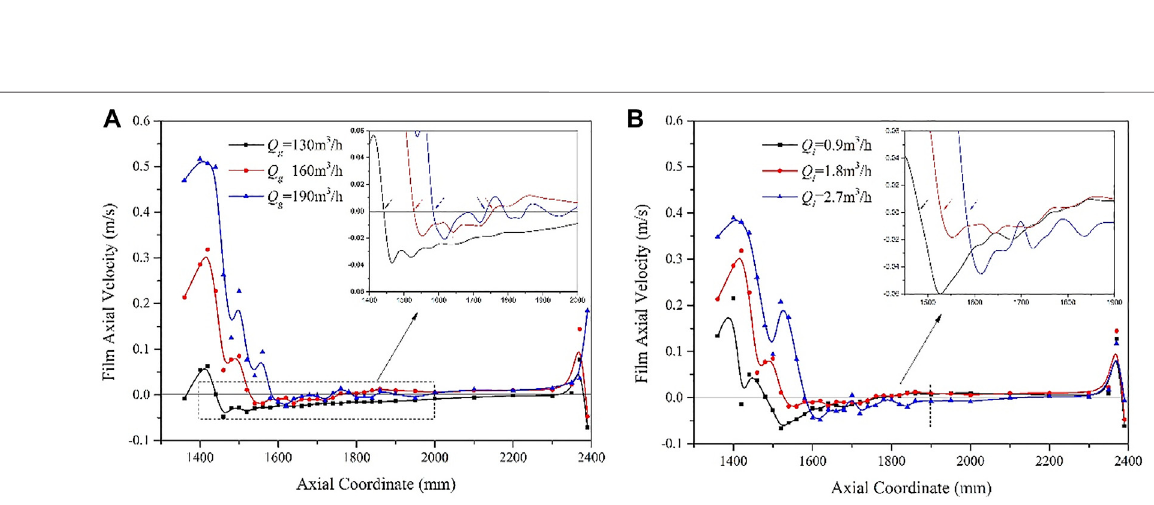
Frontiers in Chemical Engineering |